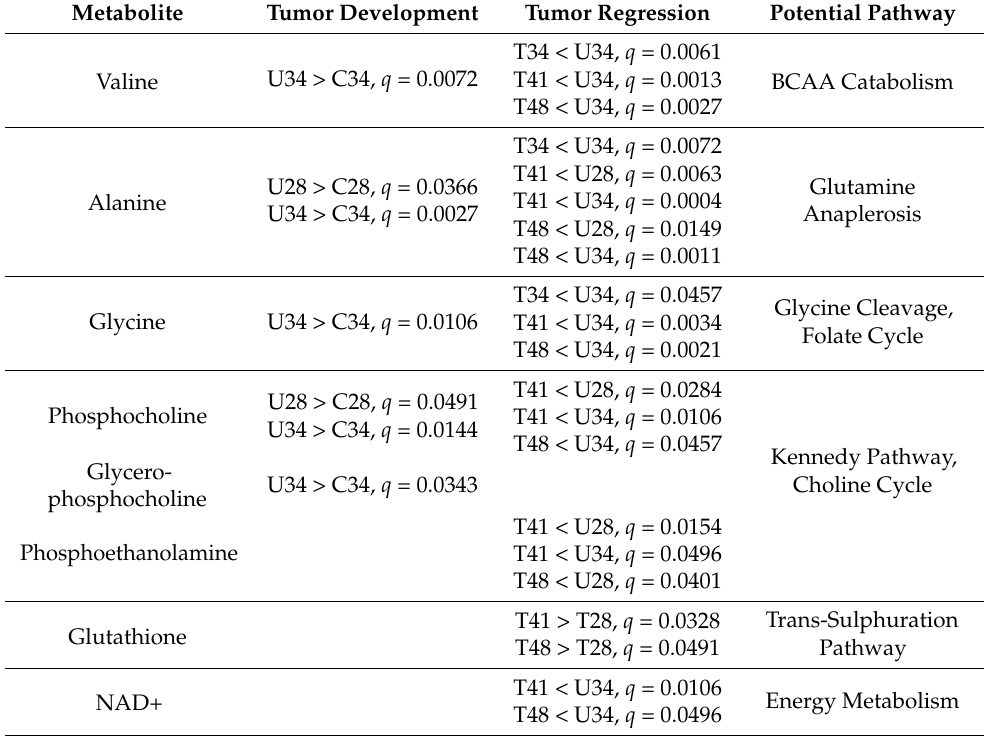
Table 1. List of significantly altered metabolites during tumor development and/or tumor